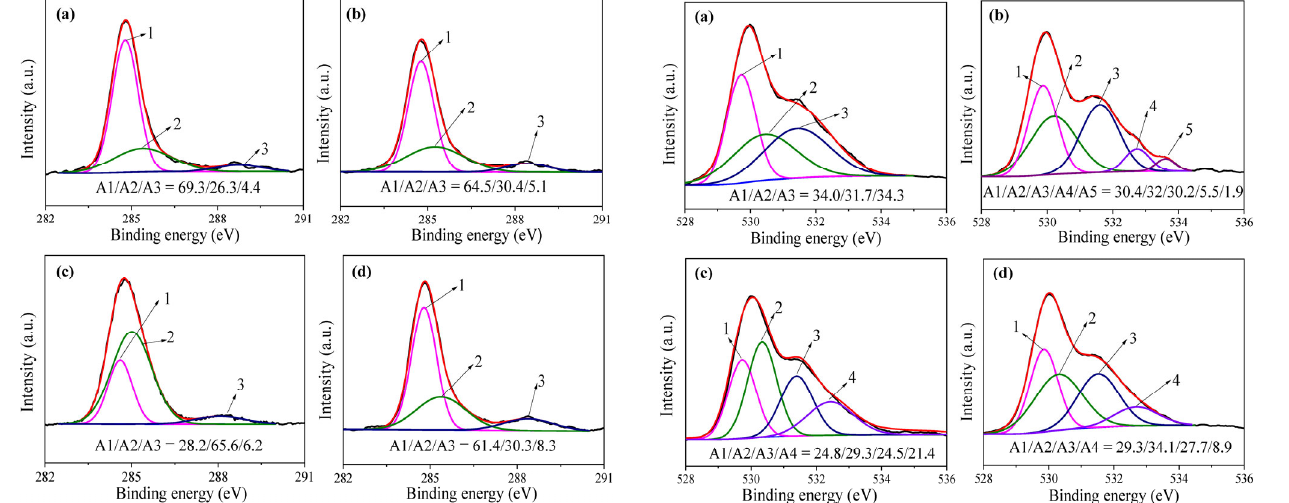
Fig. 13 XPS spectra of O 1s of the rubbed surfaces lubricate by PAO6 containing different mass concentrations of TiL 4 /BP nano- composites under the load of 20 N: (a) 0%, (b) 0.005%, (c) 0.01%, and (d)